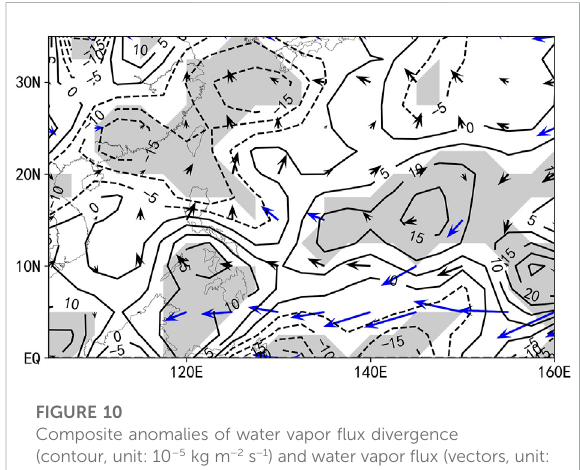
Composite anomalies of water vapor fl ux divergence (contour, unit: 10 – 5 kg m − 2 s − 1 ) and water vapor fl ux (vectors, unit: